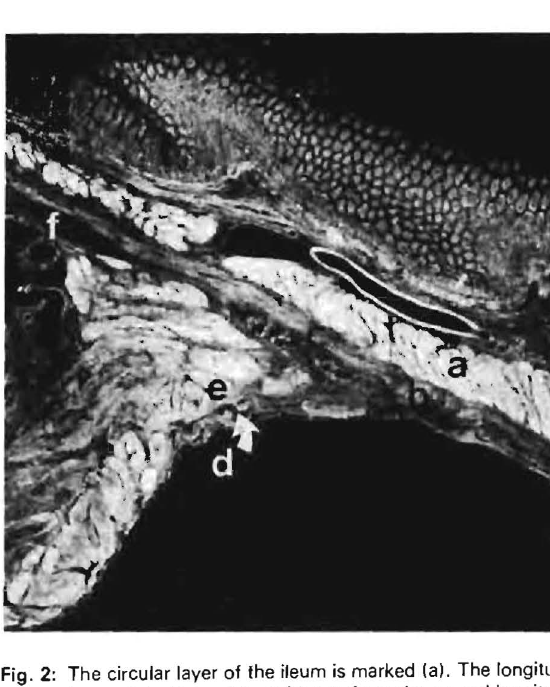
Fig. 1: A schematic drawing of the muscle layers at the ileocaecal junction with a wedge cut out between the dorsal mesenterial attachment and the ileocaecal fold. The circular muscle layer of the ileum (ai, extends into the papilla, forming the inner most circular muscle layer of the papilla. The longitudinal layer of the ileum (b), divides at the base of the caecum to form (c), the middle longitudinal layer of the papilla. The other part extends on to the caecum, contributing to the dorsal caecal taenia IdJ. The circular layer of the caecum (e), forms a spindle-shaped opening allowing the ileum to telescope into the caecal wall thereby allowing the caecal circular muscle layers to form two semicircular lips reflected on both sides on to the ileal musculature of the papilla